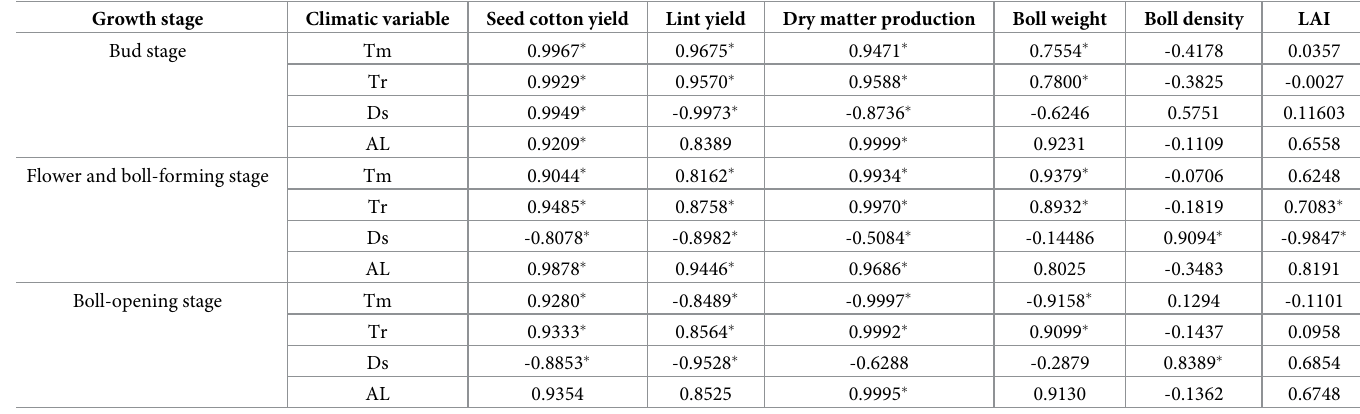
Table 5. Relationships between cotton yield attributes and meteorological conditions during bud stage, flower and boll-forming stage, and boll-opening stage. Growth